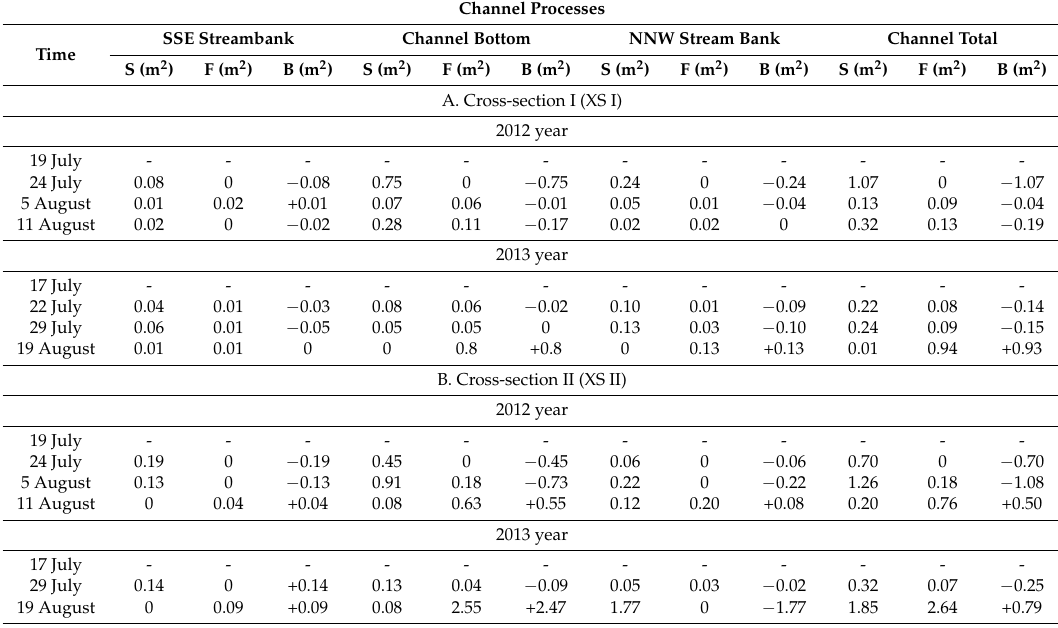
Table 3. Variability of channel processes and intensity of streambank erosion in the Scott River catchment outlet in the years 2012 and